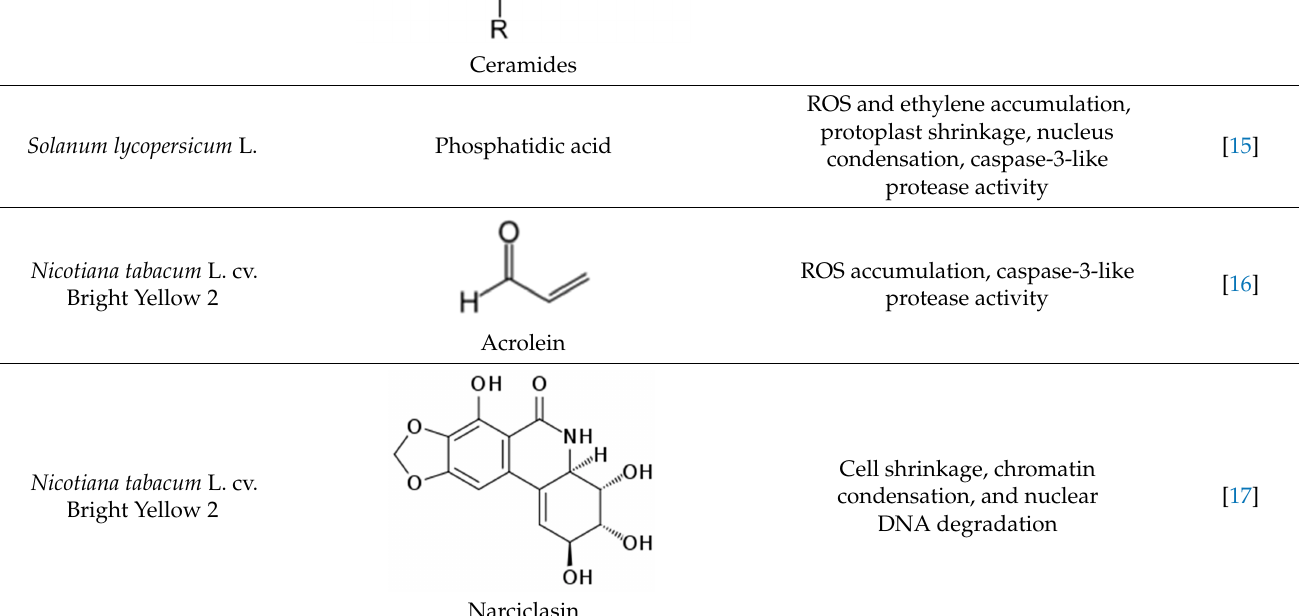
Arabidopsis thaliana (L.) Heynh.